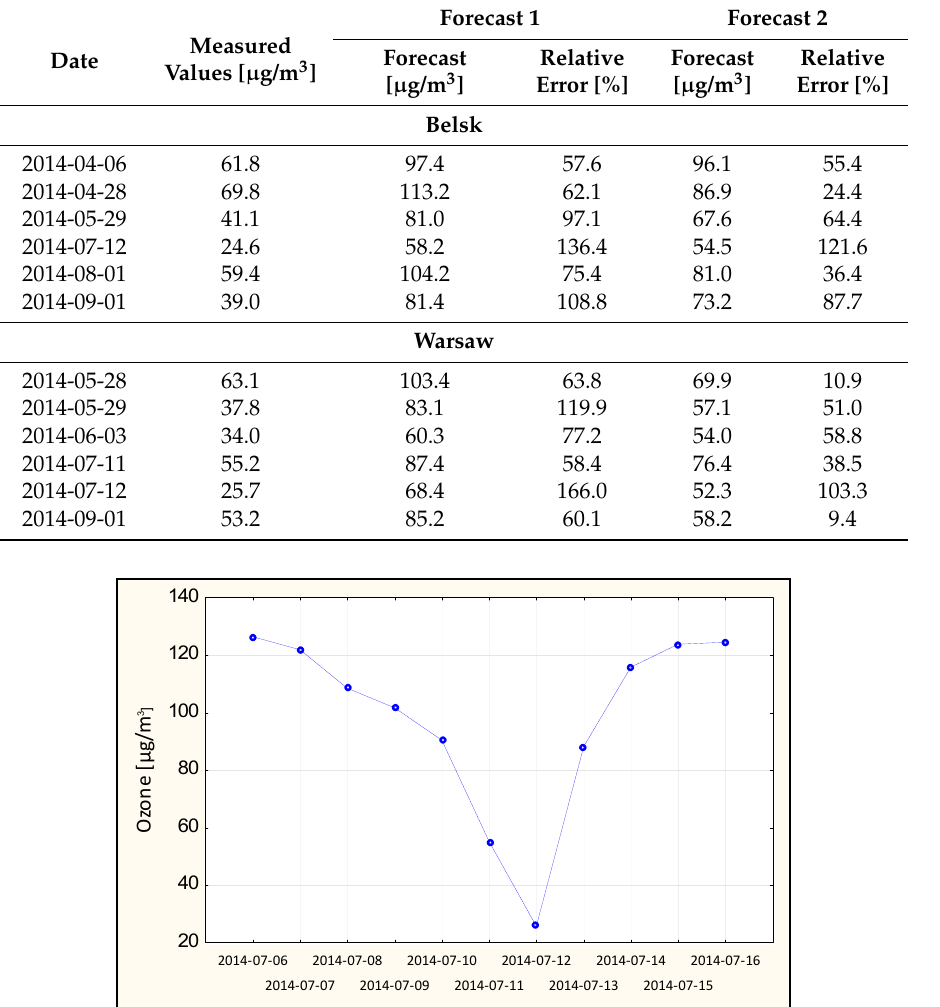
Figure 6. The daily maximum surface ozone concentration values in July 2014 at Warsaw station.